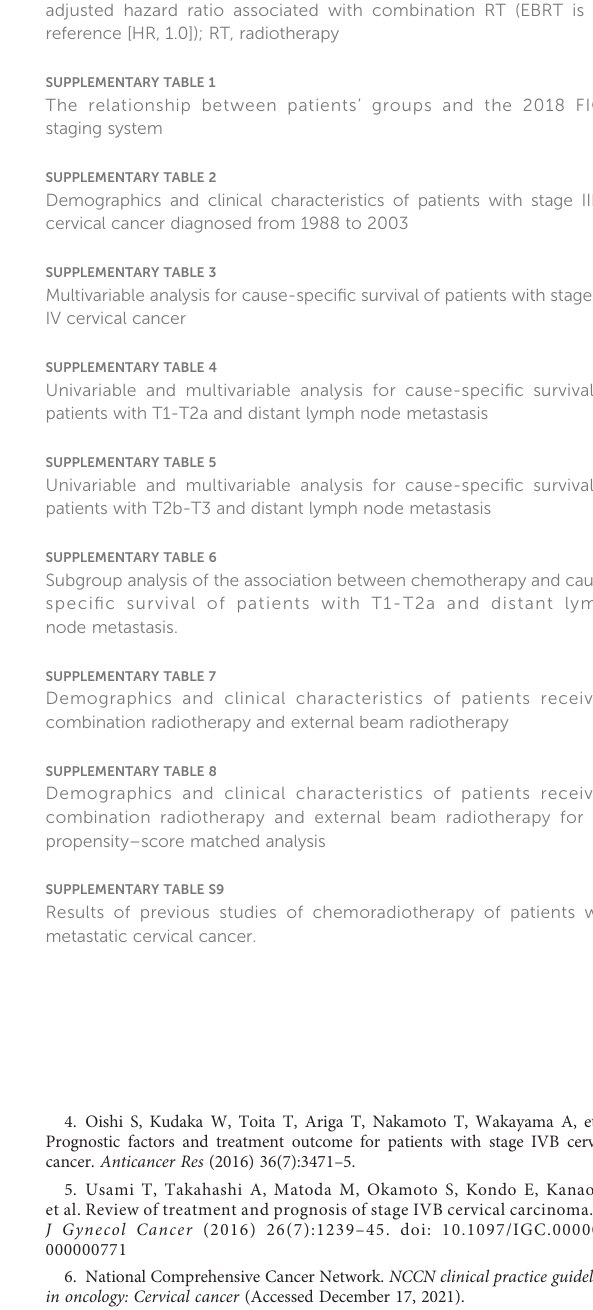
SUPPLEMENTARY FIGURE 2 Kaplan-Meier curves for cause-speci fi c survival in patients with distant lymph node metastasis (1988 – 2003). Distant lymph nodes include para- aortic lymph nodes (n=517) and other distant lymph nodes (ODLN, e.g. groin, mediastina, and supraclavicular lymph nodes; n=152). (A) IIIC2 vs. T1-3 ODLN+. (B) DLN+ vs. T4 (survival curves of stage IIIC2 and IVA as reference). DLN+, distant lymph node metastasis; ODLN+, other distant lymph node metastasis.